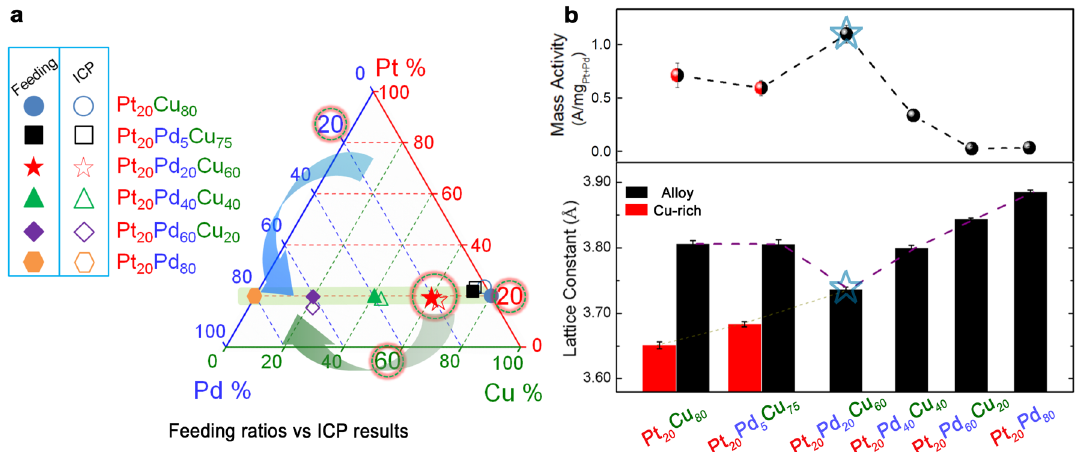
Fig. 1 The design concept for optimizing the thermodynamic stability of ternary alloy catalysts in this work. a Triangle plots showing the design of Pt 20 Pd n Cu 80 – n alloy NPs in terms of Pt, Pd, and Cu atomic percentages and the actual alloy NPs of selected compositions tested in this work. b Composition correlation of the lattice constant and the mass activity. Upper panel: the mass activities. Bottom panel: the lattice constant (determined by HE-XRD/PDFs) vs. composition for the as-prepared NP catalysts (error bars represent s.d. based on three independent experiments). The red and black columns represent the Cu-rich and Pt/Pd-rich phases,